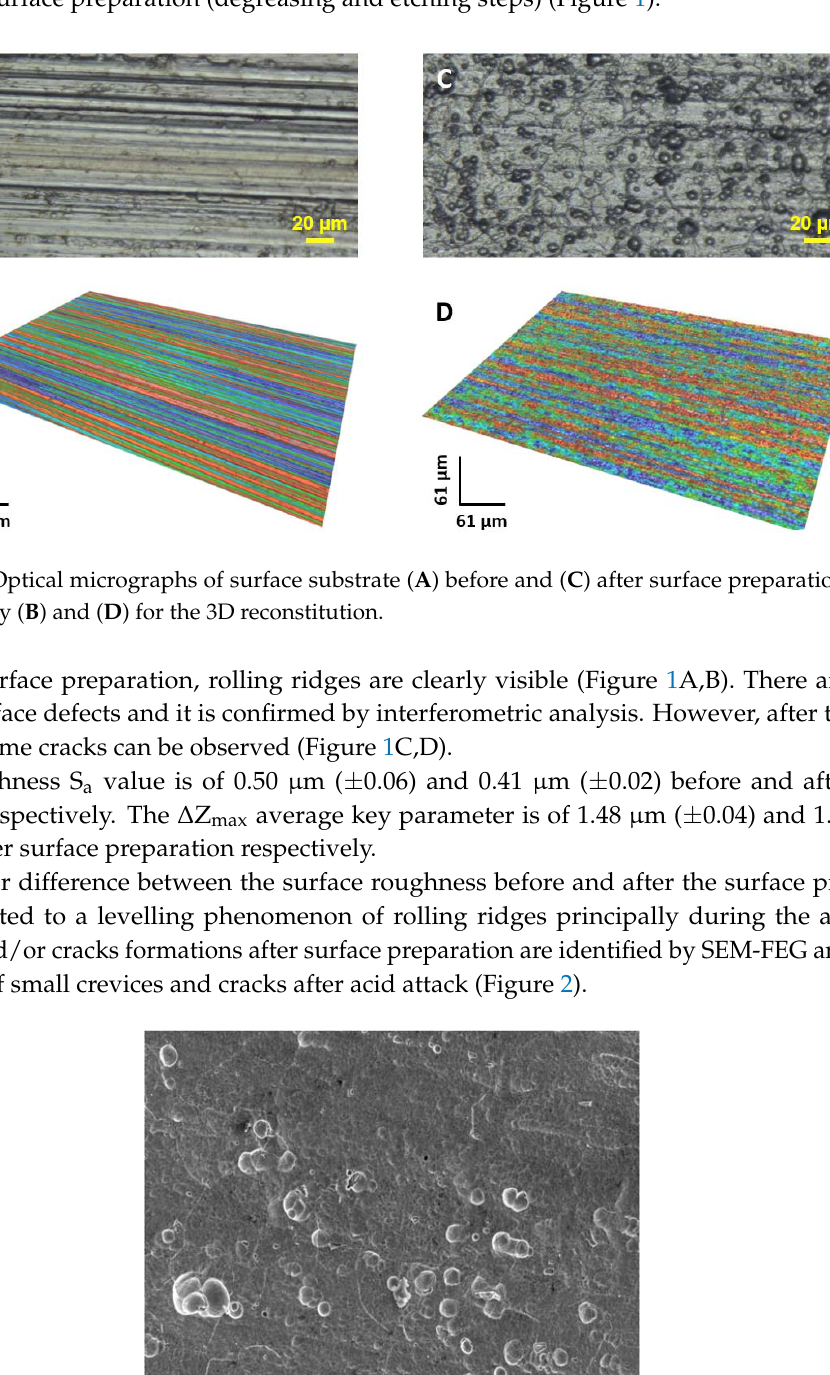
Figure 2. Substrate surface micrograph by scanning electron microscopy-field emission gun (SEM-FEG) after the surface preparation.